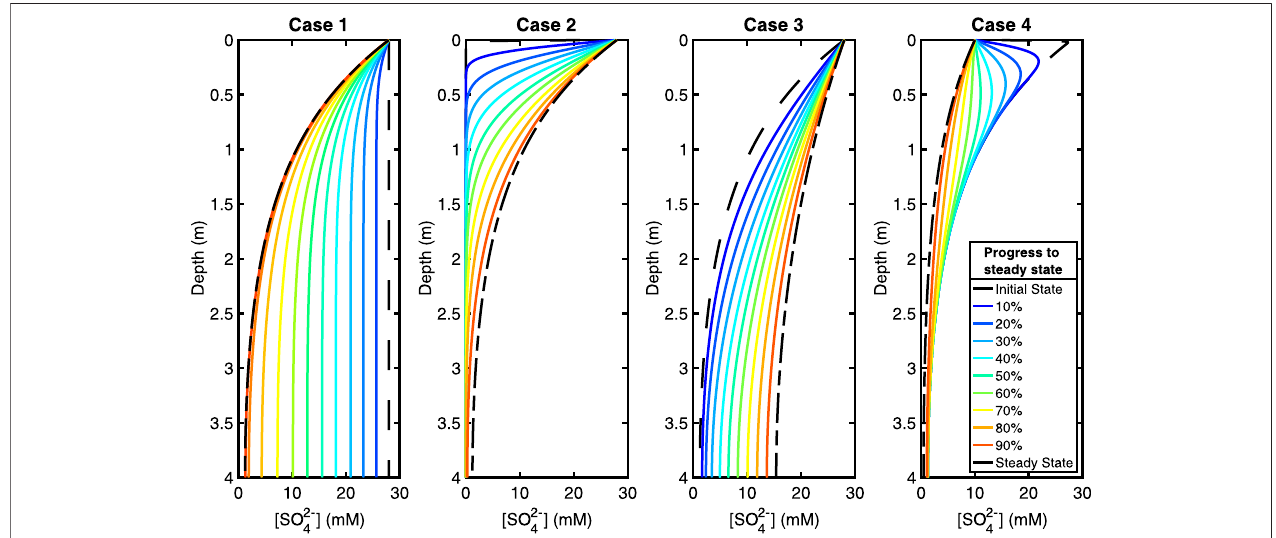
FIGURE 3 | Plots showing the evolution of the sulfate concentration with time during the approach to steady state. From left to right, test Cases 1, 2, 3, and 4. Increasing from early to late times as a percentage of the total time to steady state, going from blue (early) to red (late). See legend. See Table 3 for total steady state equilibration times. Equilibration times and concentration pro fi le behaviors are independent of recycling.